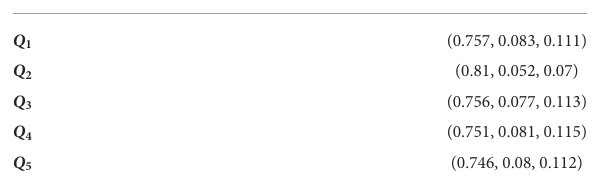
TABLE 12 The aggerating result of each company.